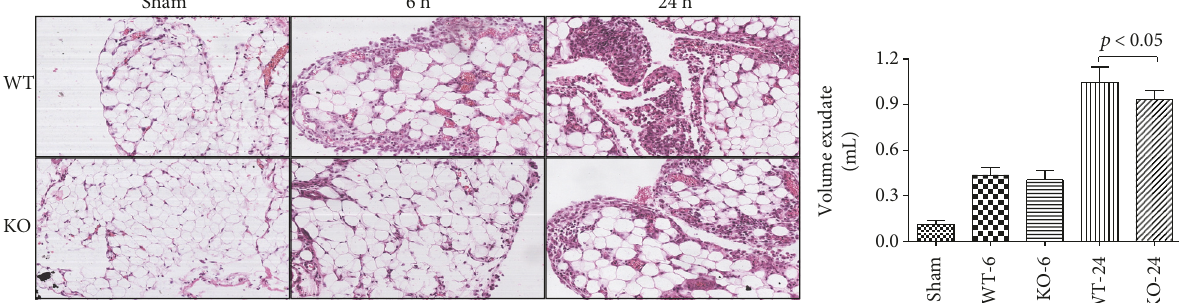
Figure 3: Lack of 5-HT alleviates peritonitis in CLP-induced sepsis in mice. The peritoneum tissue were harvested at 6 h or 24 h after CLP administration. The visceral peritoneum tissue sections were stained with H&E. Original magni fi cation 200x. Figures are representative of at least three experiments performed on di ff erent experimental days. The amount of exudate was calculated for assessment of acute peritonitis ( n = 6 , amount of exudate: mean ± SD, p < 0 05 versus the WT-CLP group at 6 h after the CLP